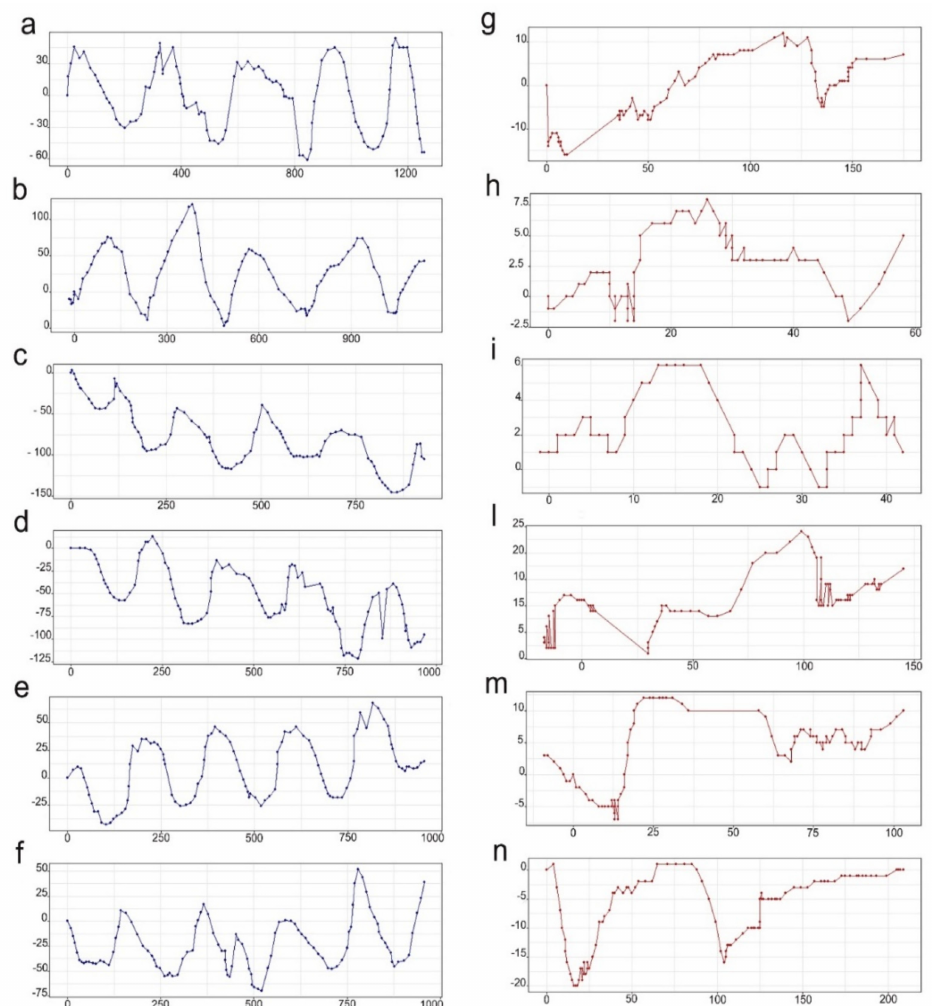
Figure 3. Locomotory patterns of 6th instar larvae ( a – f ) and prepupae ( g – n ) as described by the trajectory-tracking function of the software Kinovea. The X-axis and Y-axis indicate the horizontal and vertical components of the registered respectively